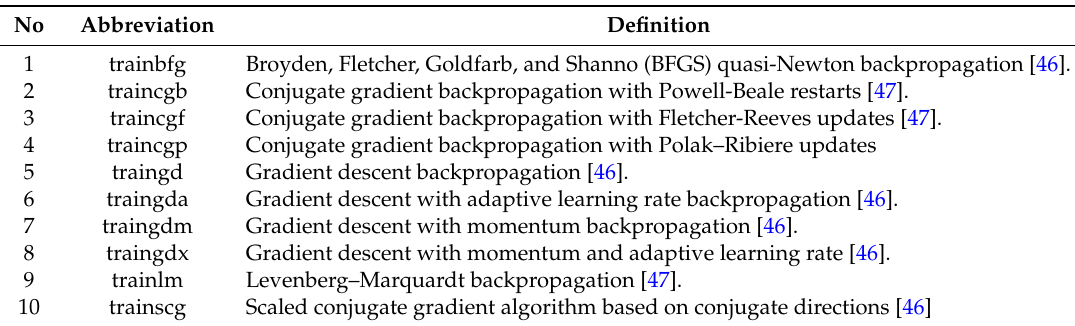
Table 1. Training algorithms used for the